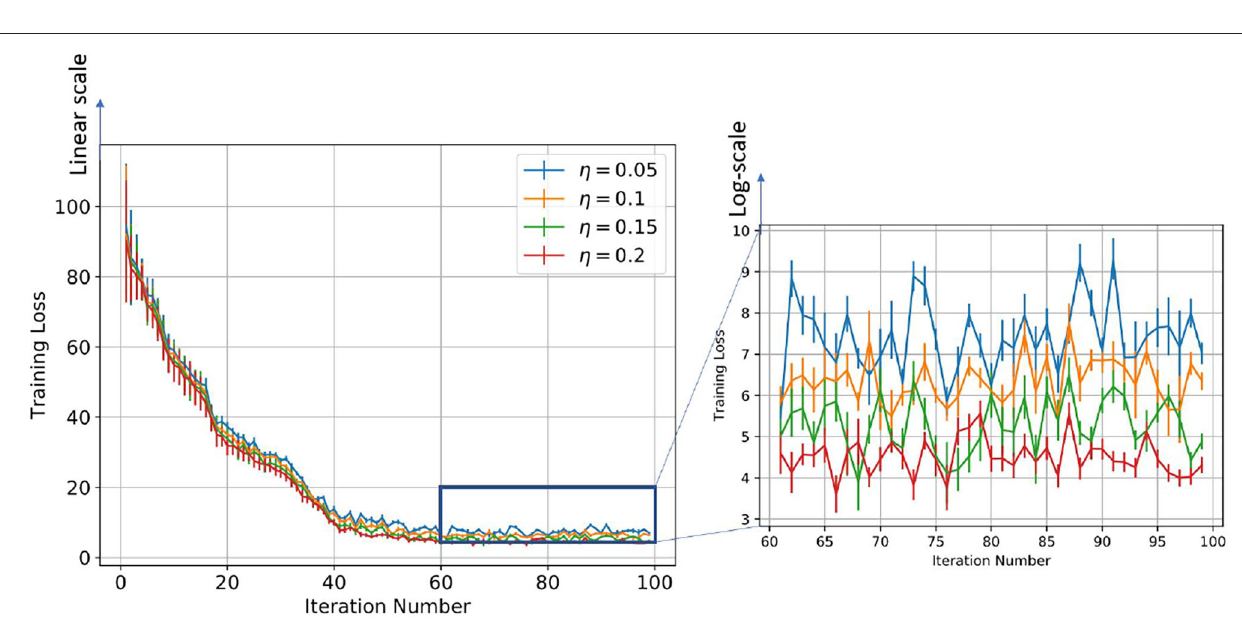
/ c c 0.9 shows a lower = + − =